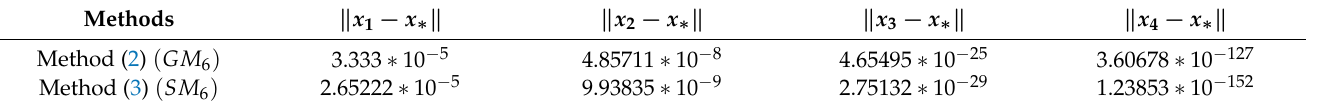
Table 1. Error estimates for Example (1).